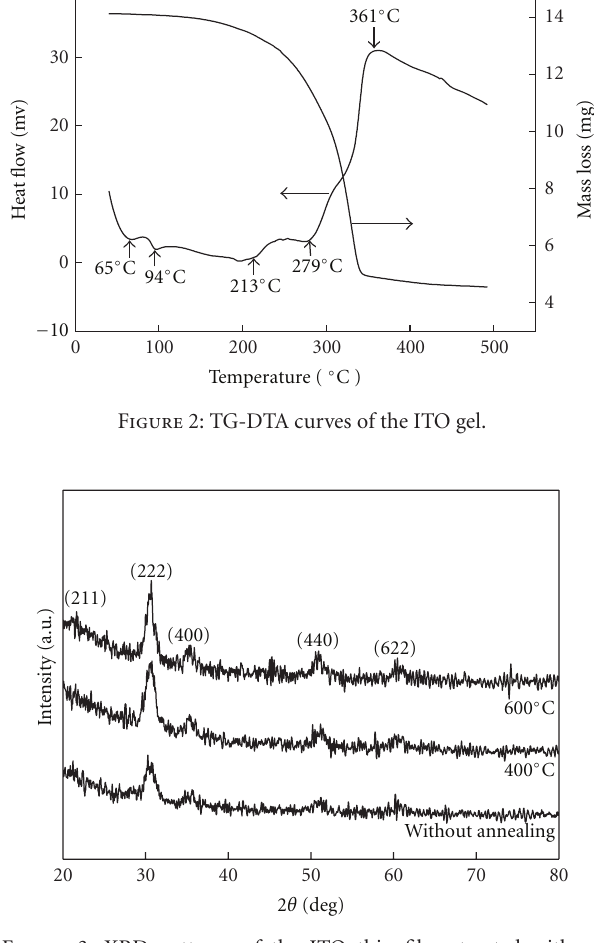
Figure 3: XRD patterns of the ITO thin films treated without annealing and with annealing at 400 ◦ C and 600 ◦ C in 3% H 2 /97% N 2 mixtures atmosphere.